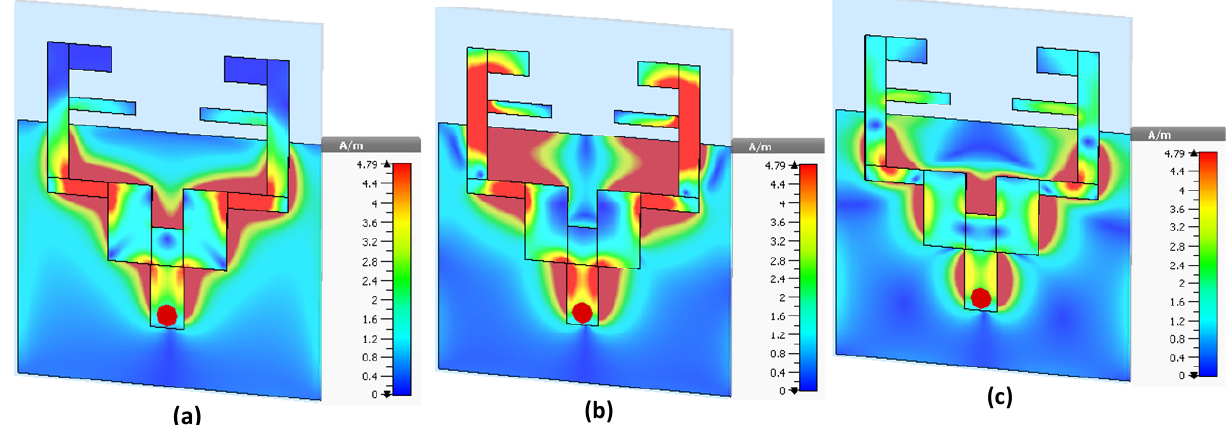
Figure 5. Surface current distribution ( a ) at 1.8 GHz, ( b ) at 3.5 GHz, and ( c ) at 5.4 GHz.